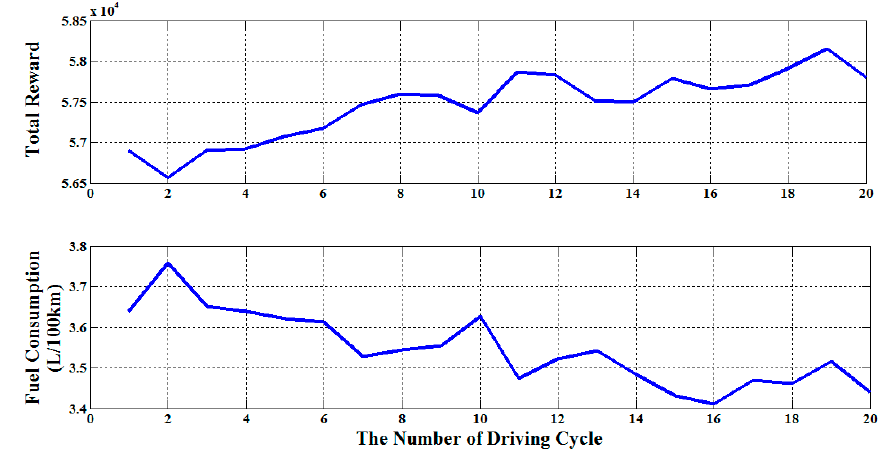
Figure 12. Track of the total reward and fuel consumption in the online application in which the EMS was pre-trained firstly.